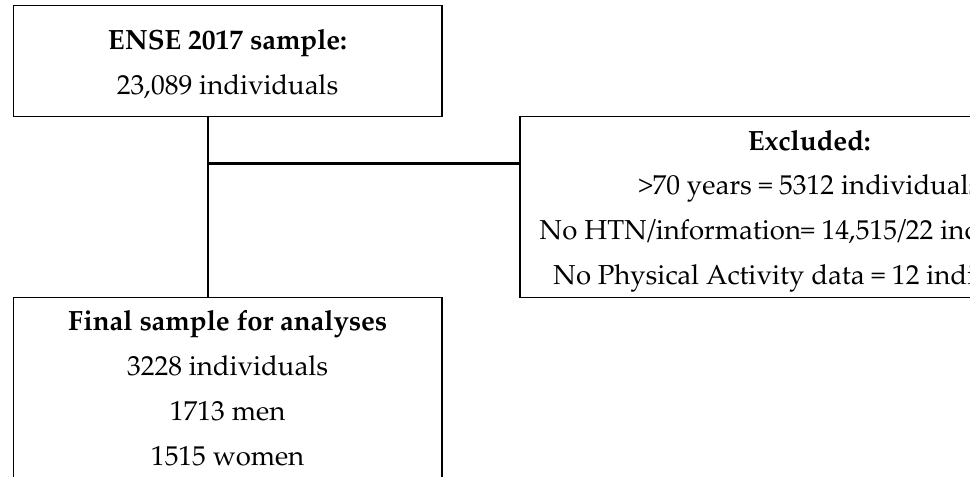
Figure 1. Chart outlining the study sample’s eligibility criteria.